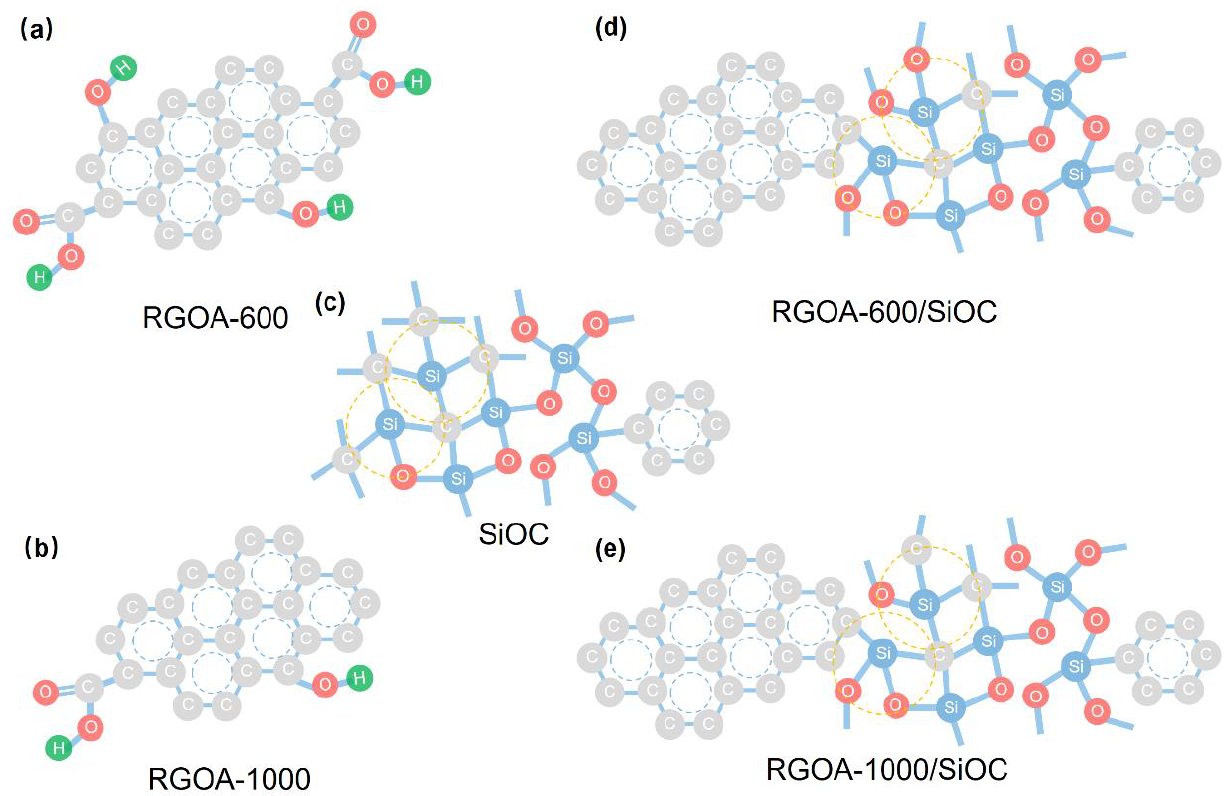
Figure 7. Schematic illustration of nanodomain structures of SiOC and reduced graphene oxide embedded SiOC samples. ( a ) RGOA-600, ( b ) 1000/SiOC, ( c ) SiOC, ( d ) RGOA-600/SiOC and ( e ) RGOA-1000/SiOC